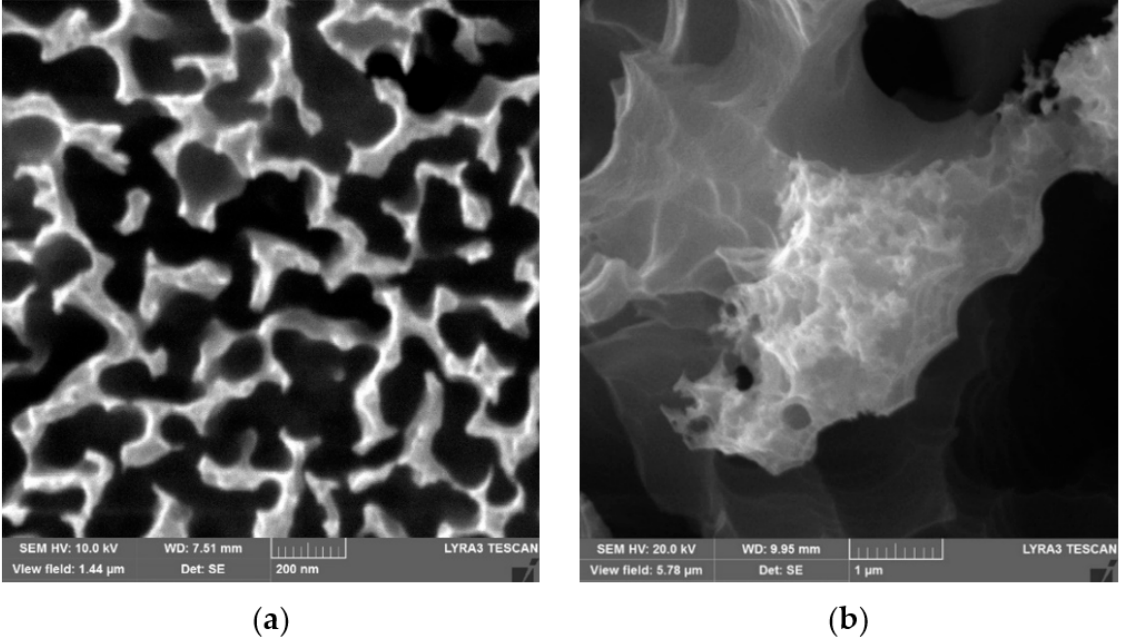
Figure 1. SEM images of top surfaces of nanowires/nanowalls: ( a ) combination of nanowires and nanowalls (nanowires are marked in circle); ( b ) nanowalls have porous-like texture on the top